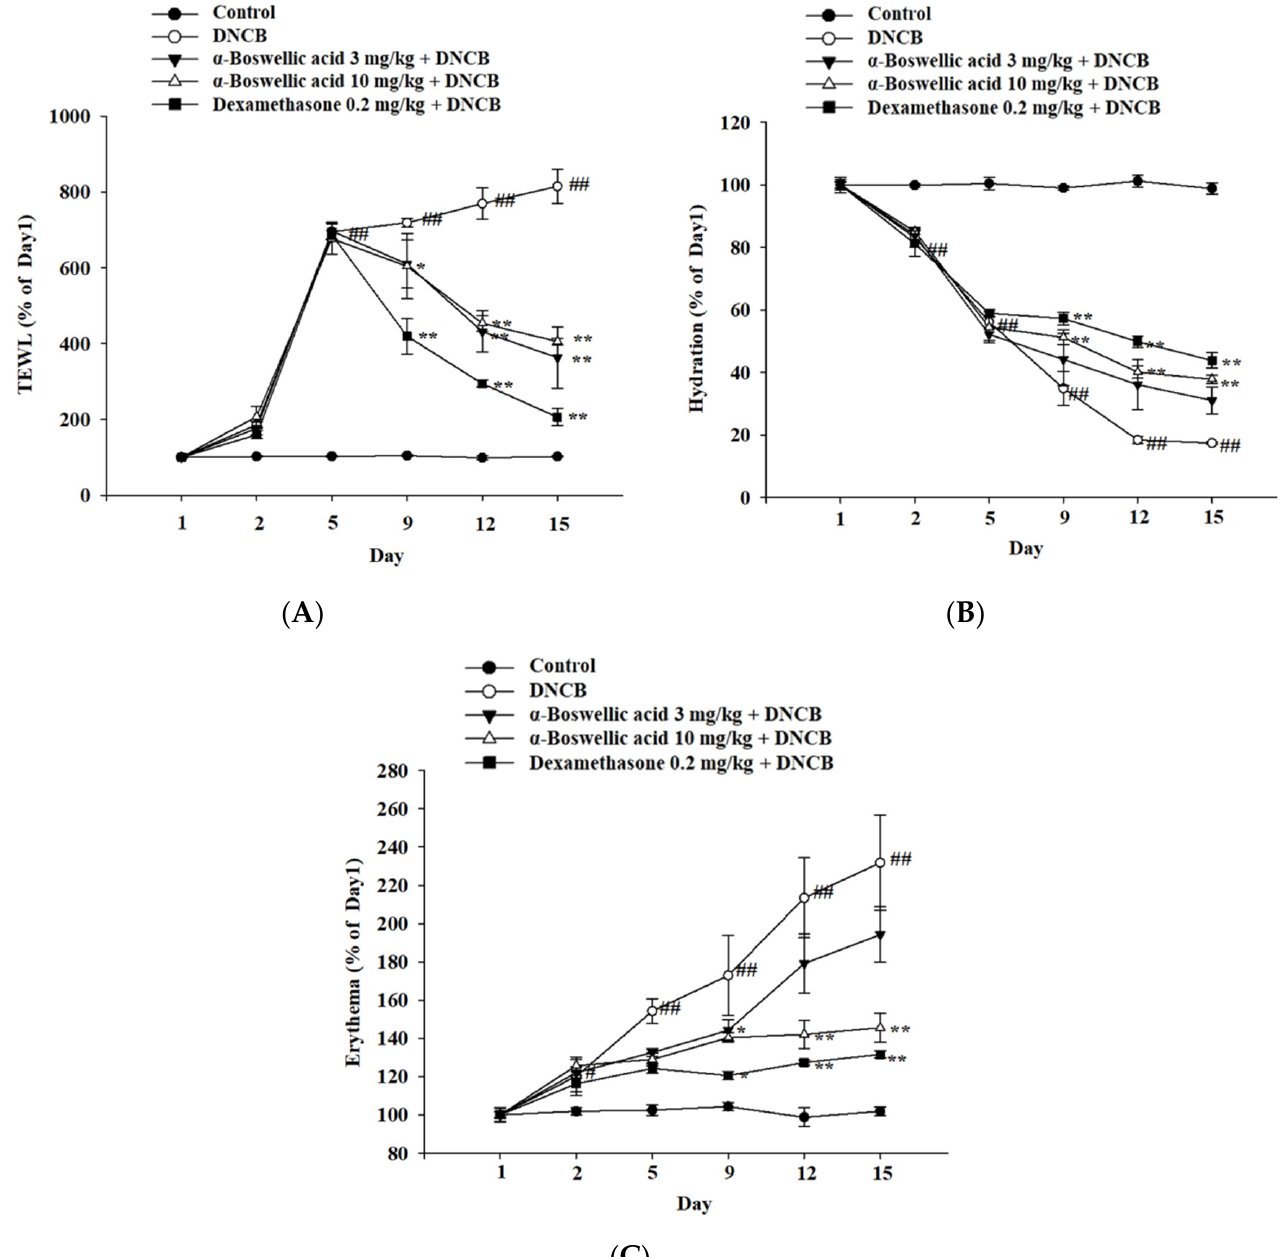
Figure 2. Effects of α -boswellic acid on TEWL, the stratum corneum hydration, and erythema of atopic dermatitis in DNCB-induced mice. Mice were treated with intraperitoneal injection with boswellic acid. ( A ) TEWL; ( B ) stratum corneum hydration; and ( C ) erythema. Values represent the mean ± SEM from three independent experiments. * p < 0.05 and ** p < 0.01 vs. the DNCB-only- treated group; # p < 0.05 and ## p < 0.01 vs. the untreated group. AD, atopic dermatitis; DNCB, 2,4-dinitrochlorobenzene; TEWL, transepidermal water